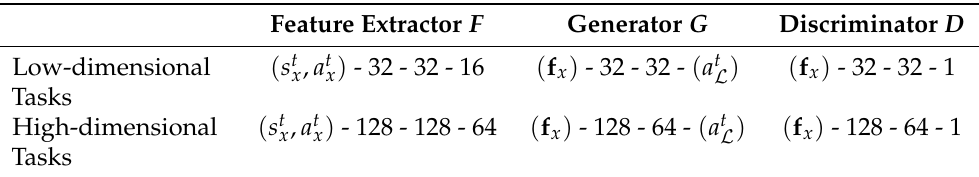
Table 2. DAIL-GAN hyperparameters used in the experiment. Each number corresponds to the number of nodes in a network